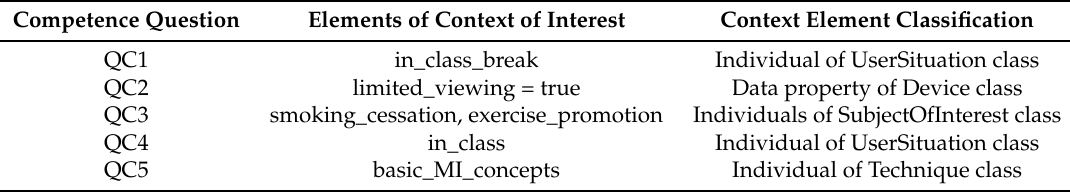
Table 7. Context elements of interest related to each competence question.